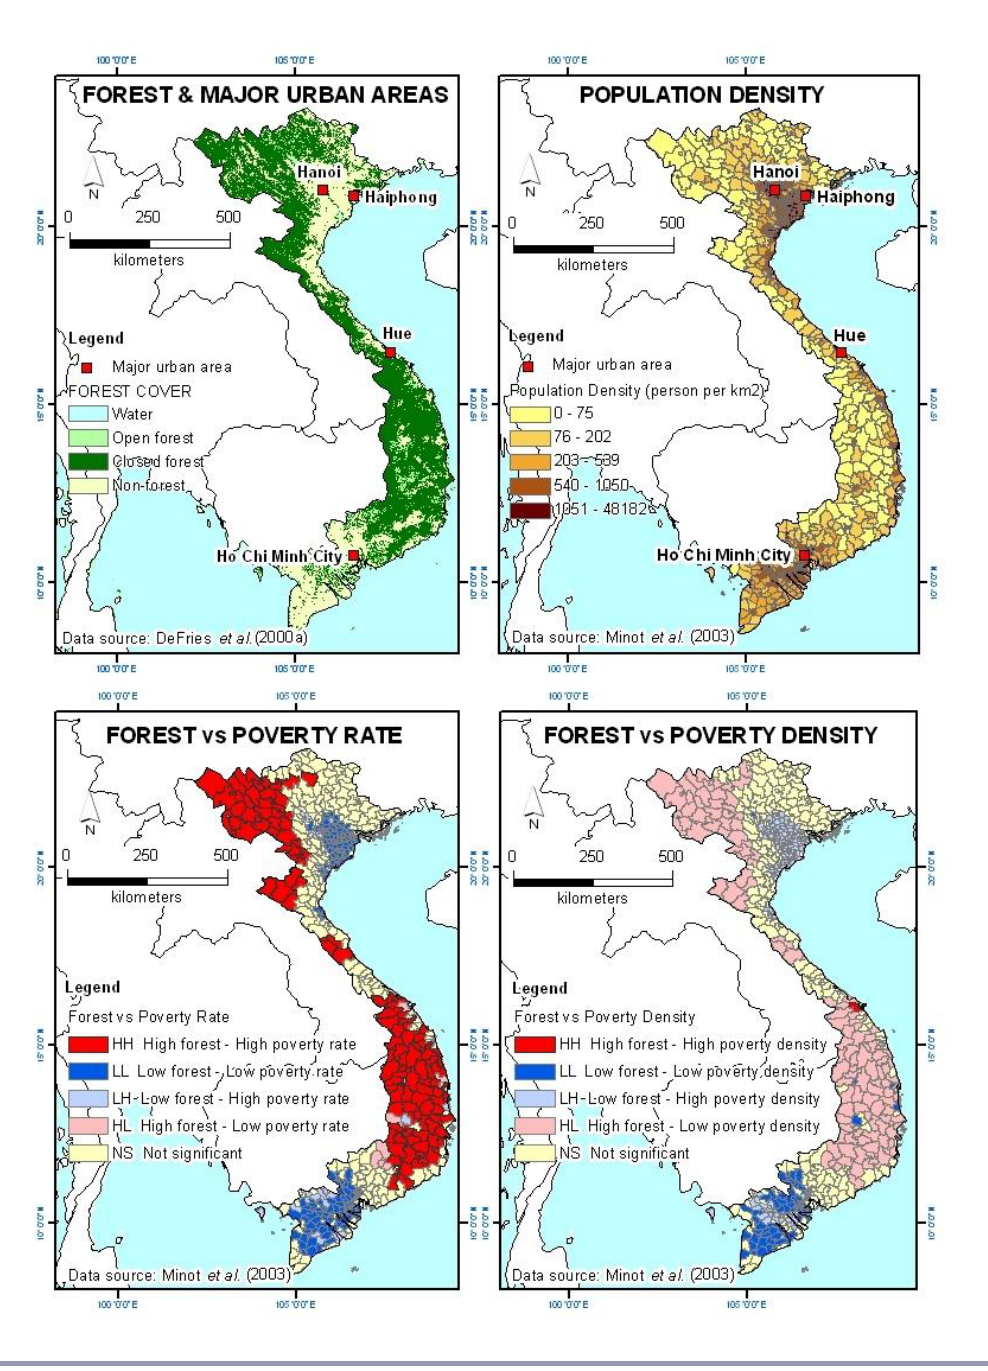
Fig. 7. Vietnam. Maps of forest and major urban areas, population density, local indicators of spatial association (LISA) analysis of forest cover by poverty rate, and LISA analysis of forest cover by poverty